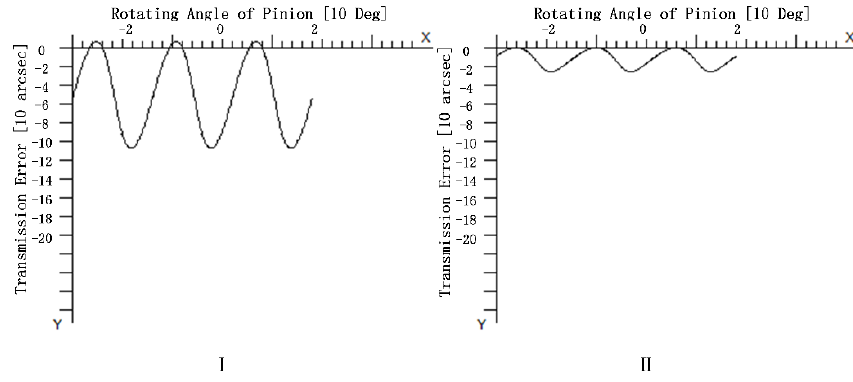
Figure 15. LTE curves at a load of 300 N · m: ( I ) Unmodified; ( II ) Modification.